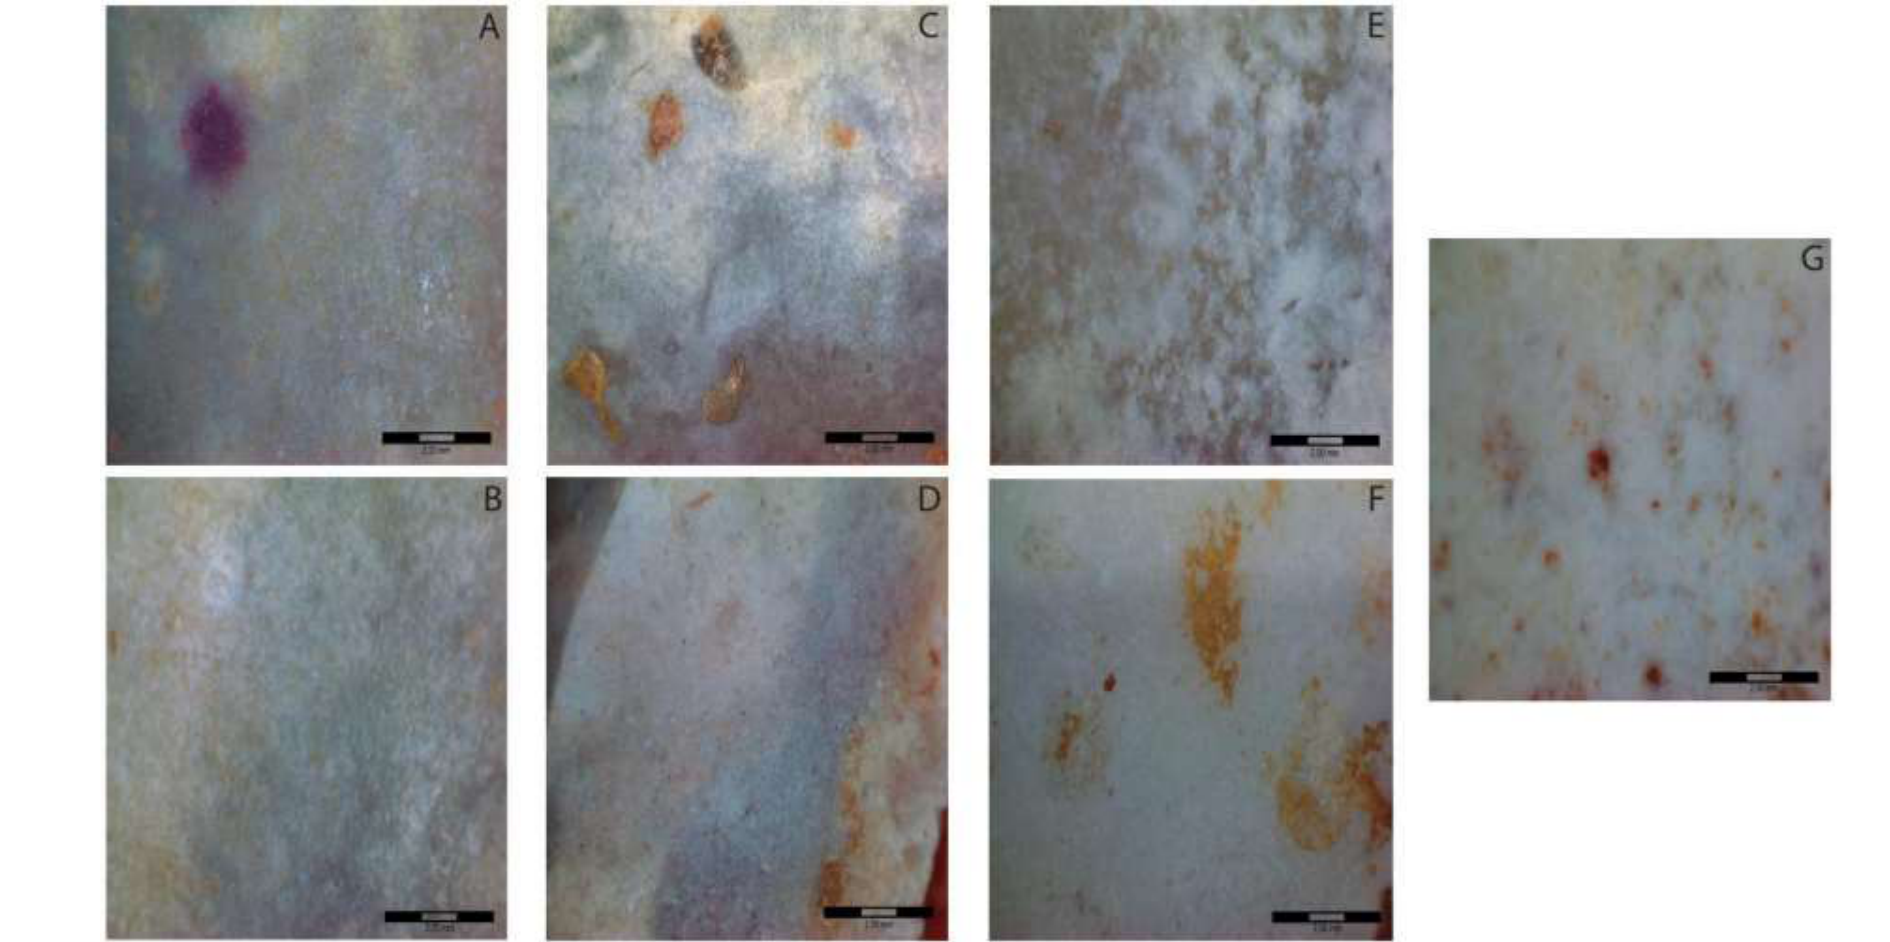
Figure 4. Mesoscopic aspects (x50) of the flint that characterizes the studied assemblage. Type 1: 4A and 4B; Type 2: 4C and 4D; Type 3: 4E and 4F; Type 4: 4G. The scale bars are 2 mm in total. Each segment is 0.67